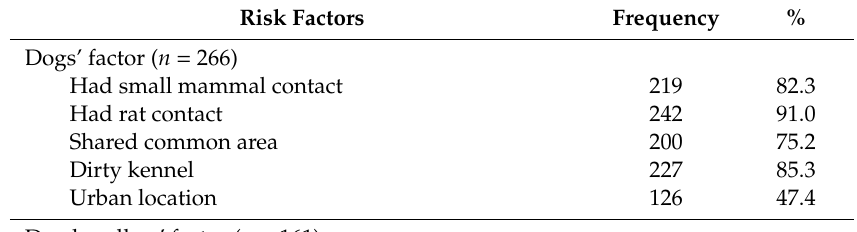
Table 1. Descriptive analysis of dogs’ and dog handlers’ exposure to risk factors identified in this study.